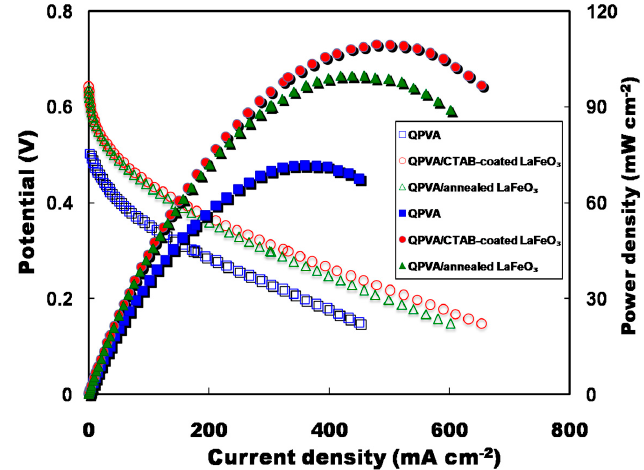
Figure 7. Direct alkaline methanol fuel cell voltage ( left axis) and power density ( right axis) as a function of current density using QPVA, QPVA/CTAB-coated LaFeO 3 , and QPVA/annealed LaFeO 3 electrolytes at 30 °C and 4 M methanol.